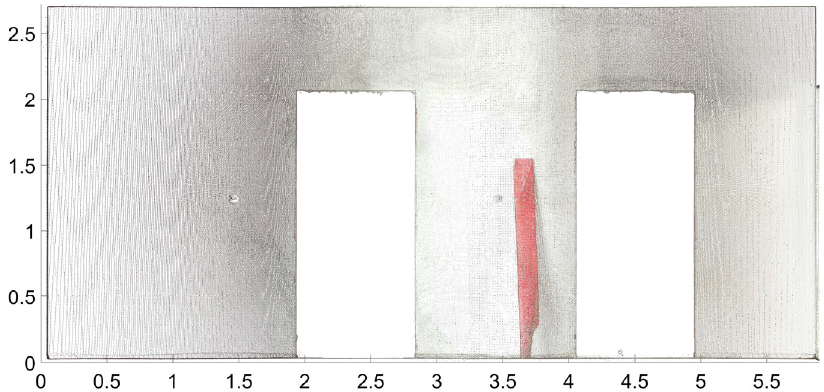
Figure 15. Scanned point cloud—wall no. 7.